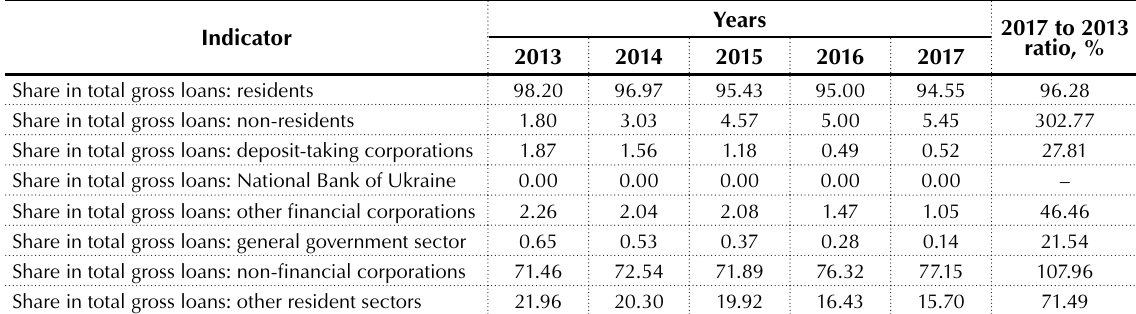
Source: National Bank of Ukraine; World Bank, database.